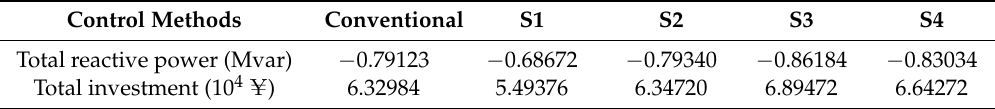
Table 1. Required total reactive power compensators and investment of different control modes.